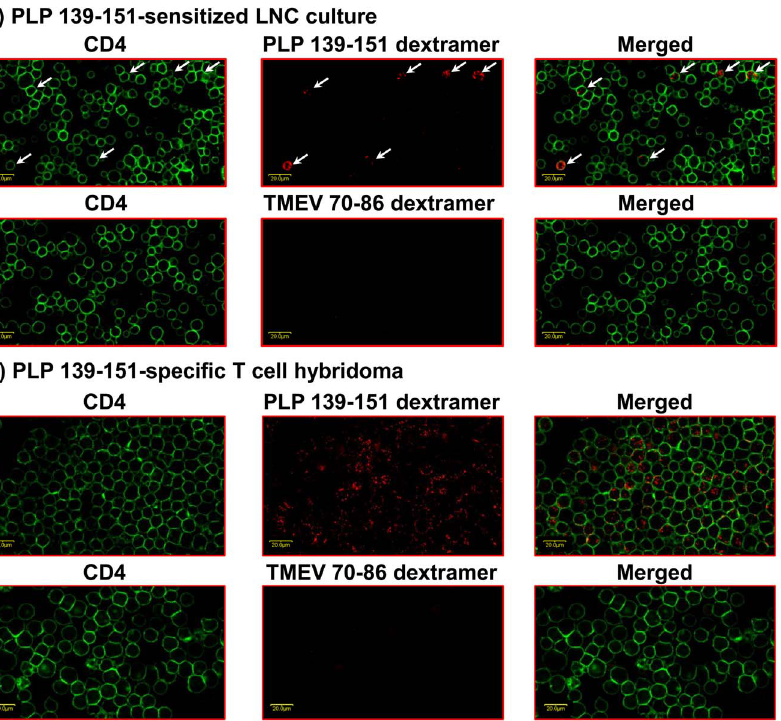
Figure 1. Evaluation of the specificity of PLP 139–151 dextramers by confocal microscopy invitro . For dextramer staining, two cell sources were used: (a) PLP 139-151-sensitized LNCs obtained from immunized mice; and (b) PLP 139-151-specific T cell hybridoma clone (B8). Viable cells harvested from LNC cultures on day 6 poststimulation, and also hybridoma cells were stained with PLP 139–151 dextramers/anti-CD4 or TMEV 70–86 (control) dextramers/anti-CD4. After washing, cells were fixed with 0.5% paraformaldehyde and examined by LSCM. Top panels (panels, a and b): cells stained with PLP 139–151 dextramers and anti-CD4. Bottom panels (panels, a and b): cells stained with TMEV 70–86 dextramers (control) and anti-CD4. Left panels: CD4, green; Middle panels: dextramers, red; Right panels: merged. Dext + CD4 + T cells are shown with arrows for LNCs, whereas in PLP 139-151-specific hybridoma cells, the dext + CD4 + cells are shown as such throughout the field. Original magnification 600 6 ; bar =20 m m.